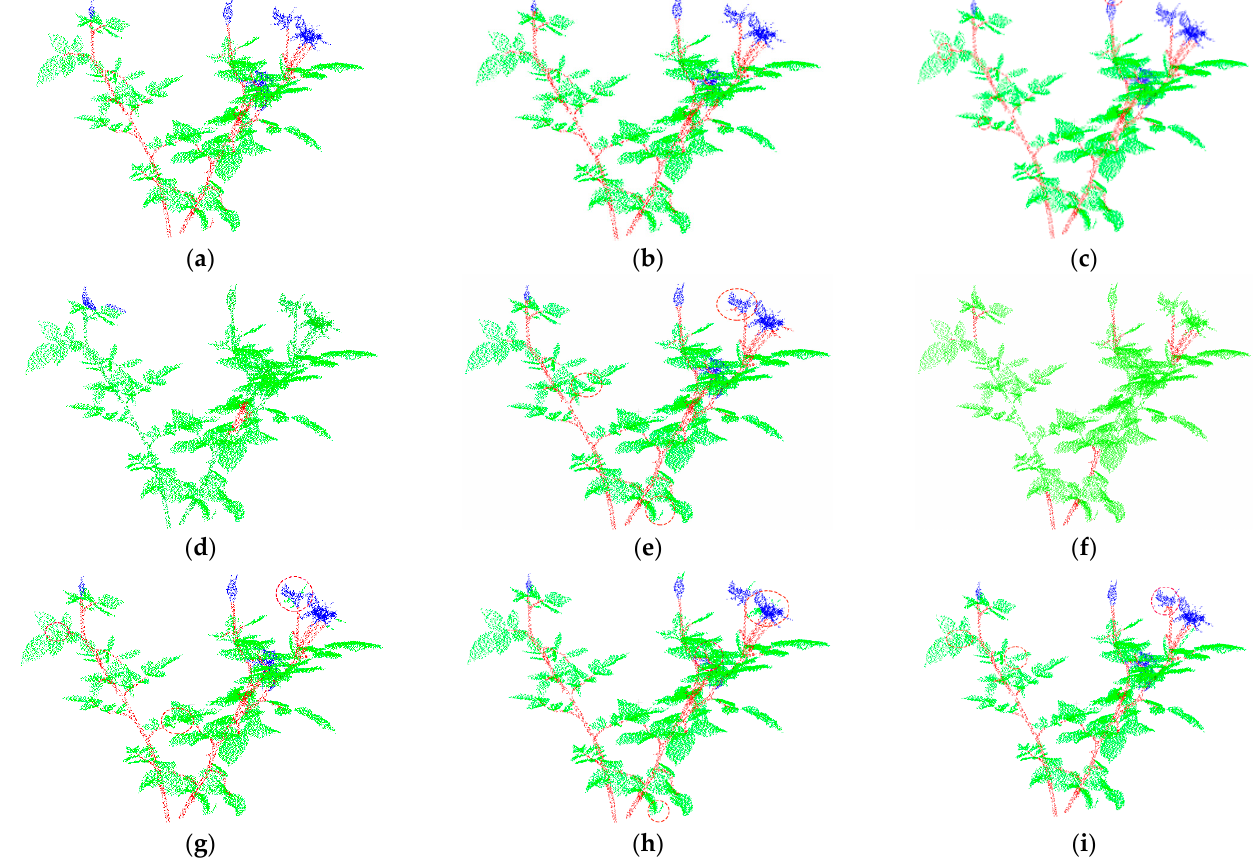
Figure 6. Segmentation result of each network on test_R2. ( a ) Ground Truth; ( b ) MASPC_Transform; ( c ) Point Transformer; ( d ) PointNet; ( e ) PointNet++; ( f ) DGCNN; ( g ) PointCNN; ( h ) ShellNet; ( i ) RICov.